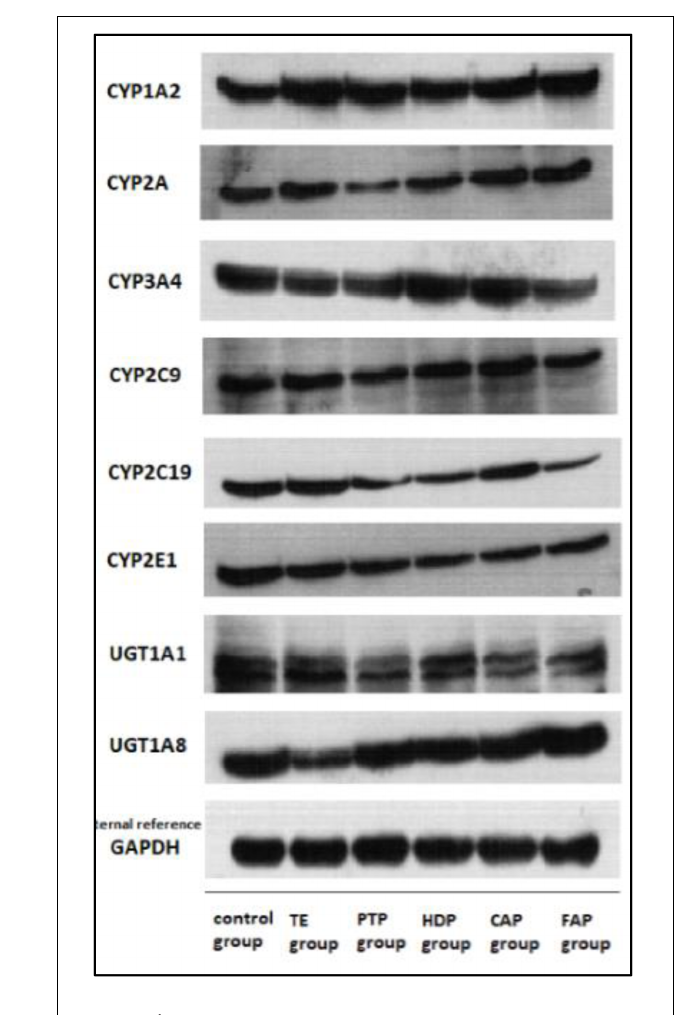
FIGURE 6 | The expression of CYP1A2, CYP2A, CYP3A4, CYP2C9, CYP2C19, CYP2E1, UGT1A1, and UGT1A8 was analyzed by western blot after administration of TE, PTP, HDP, CAP, and